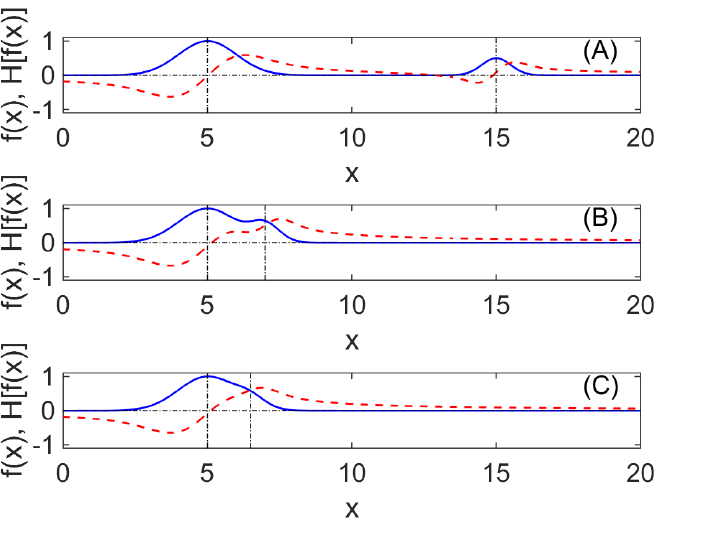
Figure 2. The functions (solid lines) combined from two Gaussians with different parameters, ( A ): A 1 = 1, A 2 = 0.5, σ 1 = 1, σ 2 = 0.5, x 01 = 5, x 02 = 15, ( B ): A 1 = 1, A 2 = 0.5, σ 1 = 1, σ 2 = 0.5, x 01 = 5, x 02 = 7, ( C ): A 1 = 1, A 2 = 0.25, σ 1 = 1, σ 2 = 0.5, x 01 = 5, x 02 = 6.5, and their Hilbert transforms (dashed lines). Vertical dash-dotted lines indicate peak positions for individual